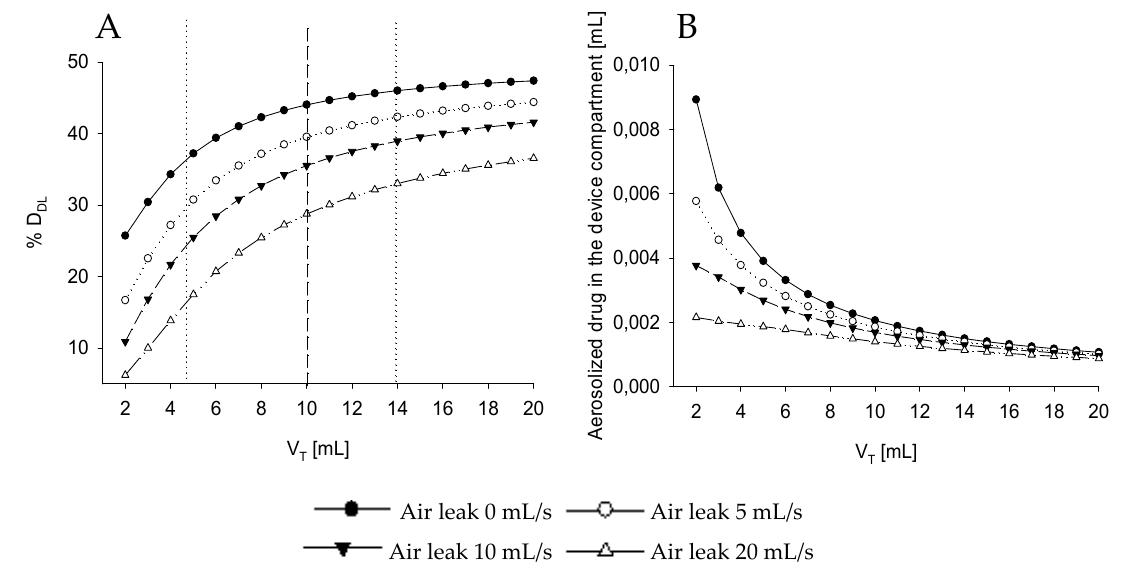
Air leak 0 mL/s Air leak 5 mL/s Air leak 10 mL/s Air leak 20 mL/s Figure 4. ( A ) Percentage of the drug delivered to the lung (%D DL ) with respect to the total drug aerosolized over multiple tidal volume V T . ( B ) Averaged amount of aerosolized drug in the device compartment in case upper airways volume compartment has been sized at 1mL. Each line refers to a di ff erent air leak from 0 mL / s to 20 mL / s. Dotted lines at V T equal to 5 and 14 mL highlight, respectively, the response of the system when two babies representing the upper and lower limit of the patient population are considered. The dashed line emphasizes the response of the system at tidal volume smaller (left) or bigger (right) than the dead space of the nebulizer. V T = tidal volume, D DL = dose delivered to the